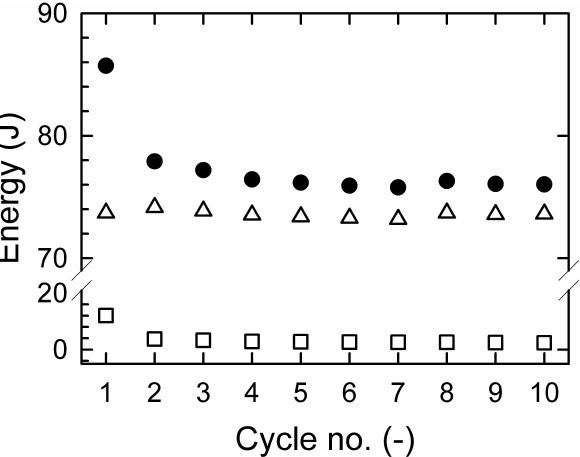
Figure 8: Results of the cyclic closed shell compression loading experiments of the calcium carbonate (sample 1) (deformation rate 10 mm/min, maximum force 80 kN): full circle – input energy (J), triangle up – stored energy (J), square – dissipated energy (J)